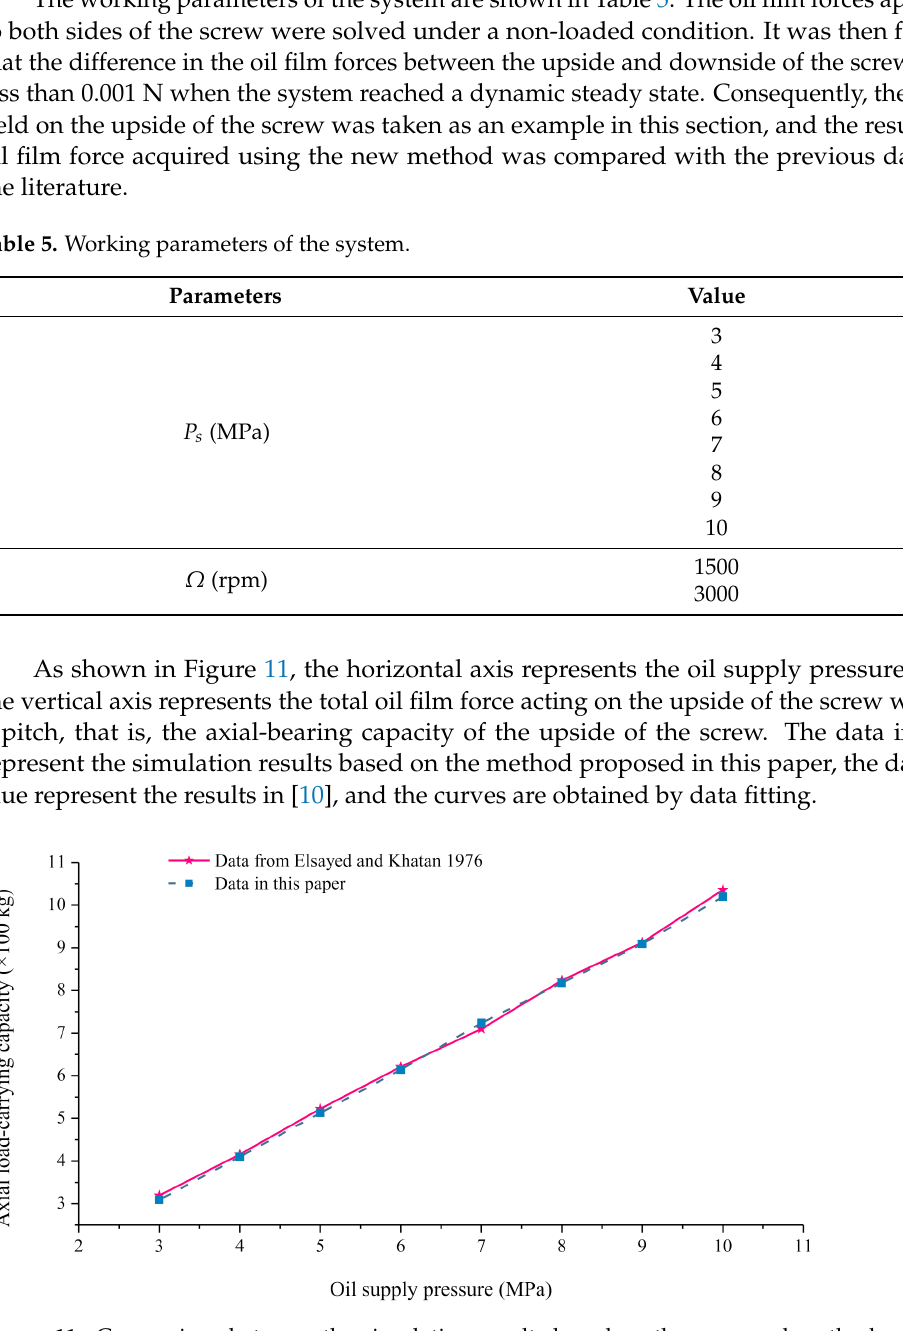
Figure 11. Comparison between the simulation results based on the proposed method and the previous data